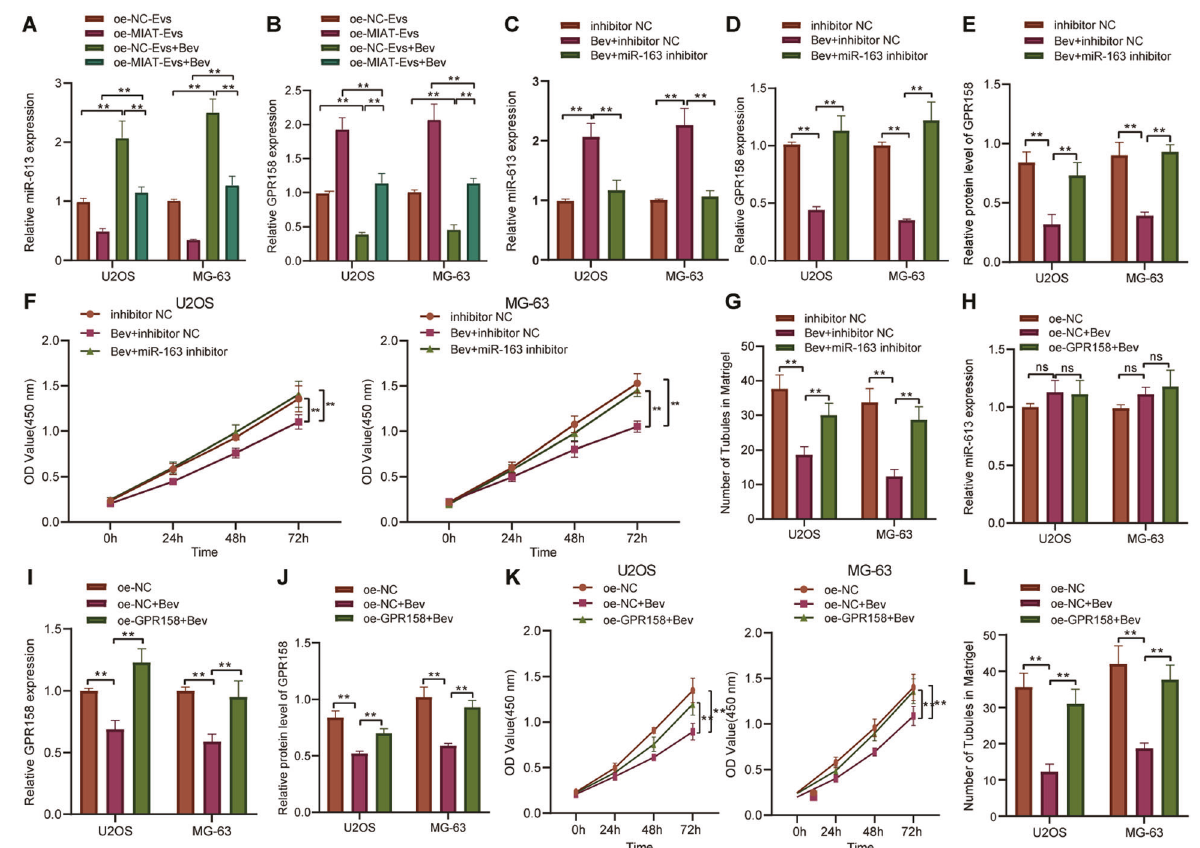
B GPR158 mRNA expression determined by RT-qPCR in U2OS and MG63 cells treated with oe-NC-EVs + Bev, oe-MIAT-EVs, or oe-MIAT-EVs + Bev. C miR-613 expression determined by RT-qPCR in U2OS and MG63 cells treated with Bev + miR-613 inhibitor. D GPR158 mRNA expression was determined by RT-qPCR in U2OS and MG63 cells treated with Bev + miR-613 inhibitor. E Western blot analysis of GPR158 protein in U2OS and MG63 cells treated with Bev + miR-613 inhibitor. F Proliferation of U2OS and MG63 cells treated with Bev + miR-613 inhibitor measured by CCK-8 assay. G Angiogenesis of U2OS and MG63 cells treated with Bev + miR-613 inhibitor measured by microtubule formation in vitro. H miR-613 expression determined by RT-qPCR in U2OS and MG63 cells treated with oe-GPR158 + Bev. I GPR158 mRNA expression determined by RT-qPCR in U2OS and MG63 cells treated with oe-GPR158 + Bev. J Western blot analysis of GPR158 protein in U2OS and MG63 cells treated with oe-GPR158 + Bev. K Proliferation of U2OS and MG63 cells treated with oe-GPR158 + Bev measured by CCK-8 assay. L Angiogenesis of U2OS and MG63 cells treated with oe-GPR158 + Bev measured by microtubule formation in vitro. * p <0.05, ** p <0.01. All experiments were conducted three times